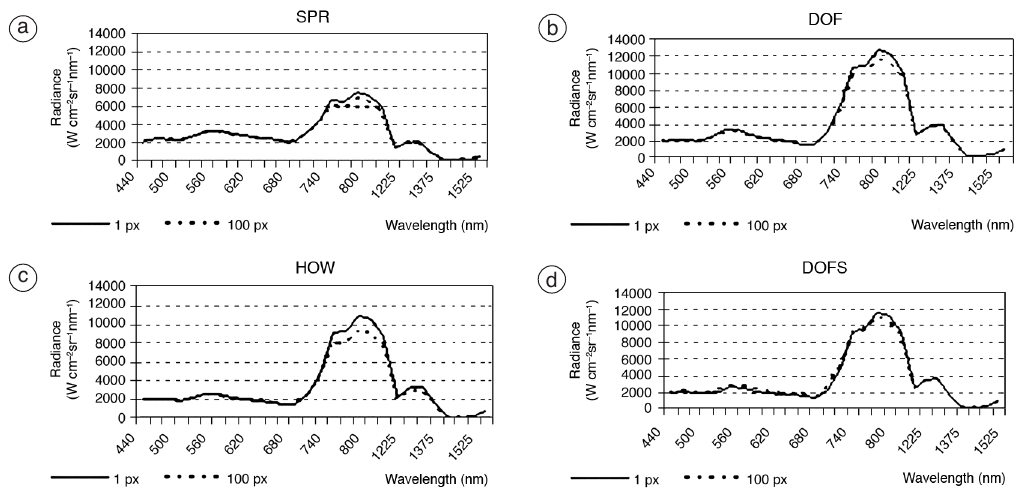
Fig. 2a-d. MIVIS spectral signatures, relative to 1 pixel and 100 pixels areas, of the studied plant typologies: a) reafforestation of Pinus pinea L. (SPR); b) deciduous oak forest with Carpinus orientalis Miller (DOF); c) sclero- phyllous vegetation with holm-oak prevailing (HOW); d) deciduous oak forest with evergreen shrubs